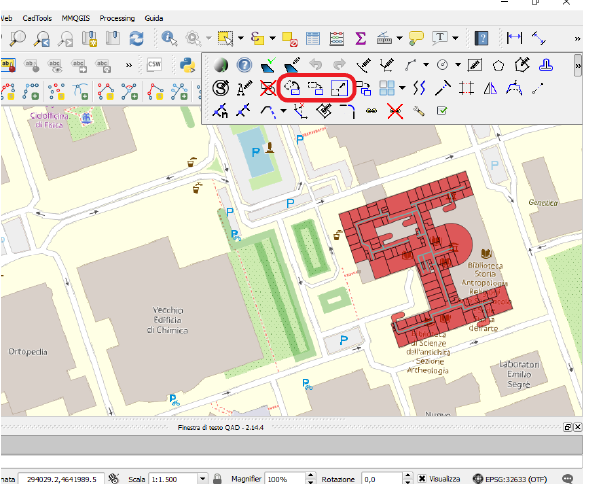
Figure 3. QAD button tool used in this step and the layout perfectly coincident with the OSM map below